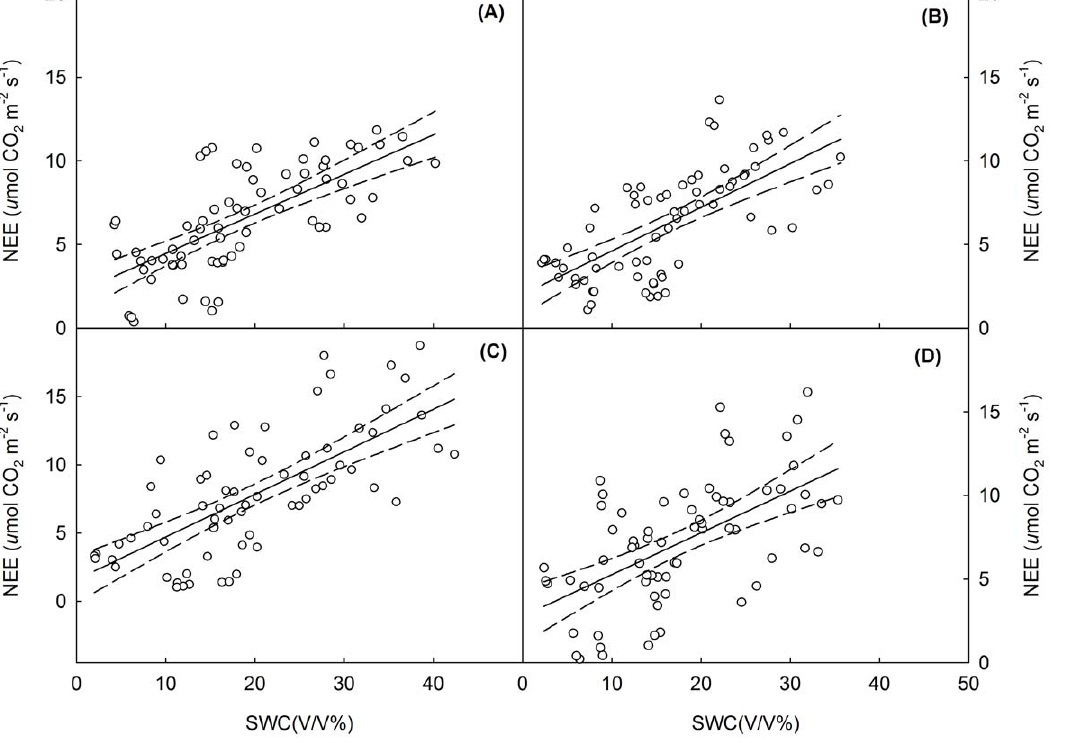
Figure 4. Temporal dependence of net ecosystem CO 2 exchange (NEE) on soil water content (SWC) across the four growing seasons. Regression lines (solid) and 95% confidence level (dotted lines) are showed. All the linear regressions are statistically significant ( P , 0.05). Regression equations and significance levels are provided in Table 4. (A), control; (B), warming; (C), N addition; (D), combined warming and N